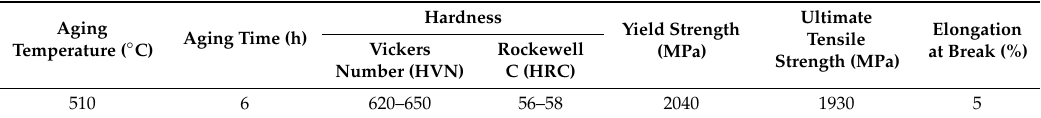
Table 3. Heat treatment conditions and mechanical properties for maraging 300 (EN 1.2709) samples tested by LORTEK [27].